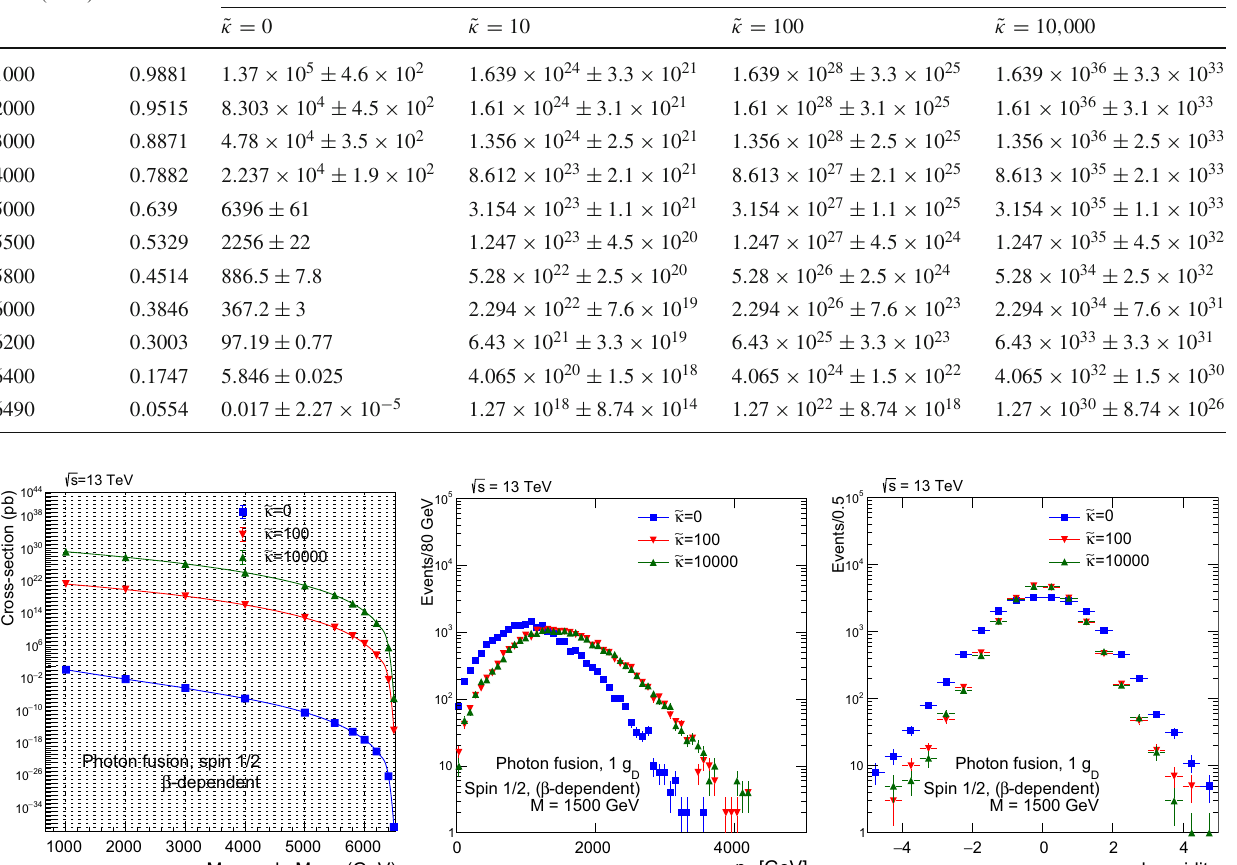
√ Fig. 26 Photon-fusion production at s = 13 TeV pp collisions for spin- 1 / 2 monopole, β -dependent coupling and various values of the ˜ κ parameter: cross section versus monopole mass (left); p T distribution for M = 1500 GeV (centre); and η distribution for M = 1500 GeV